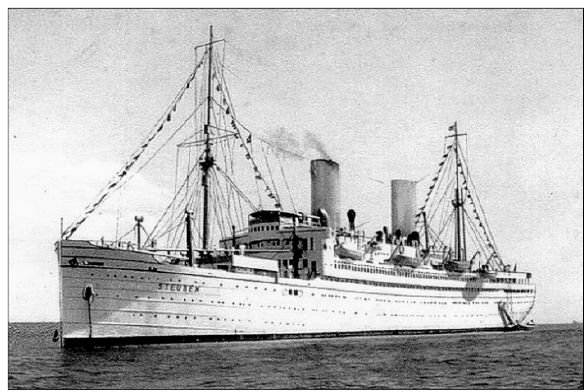
Figure 1. German passenger liner General von Steuben before sinking [22]. Table 1. Characteristics of passenger liner General von